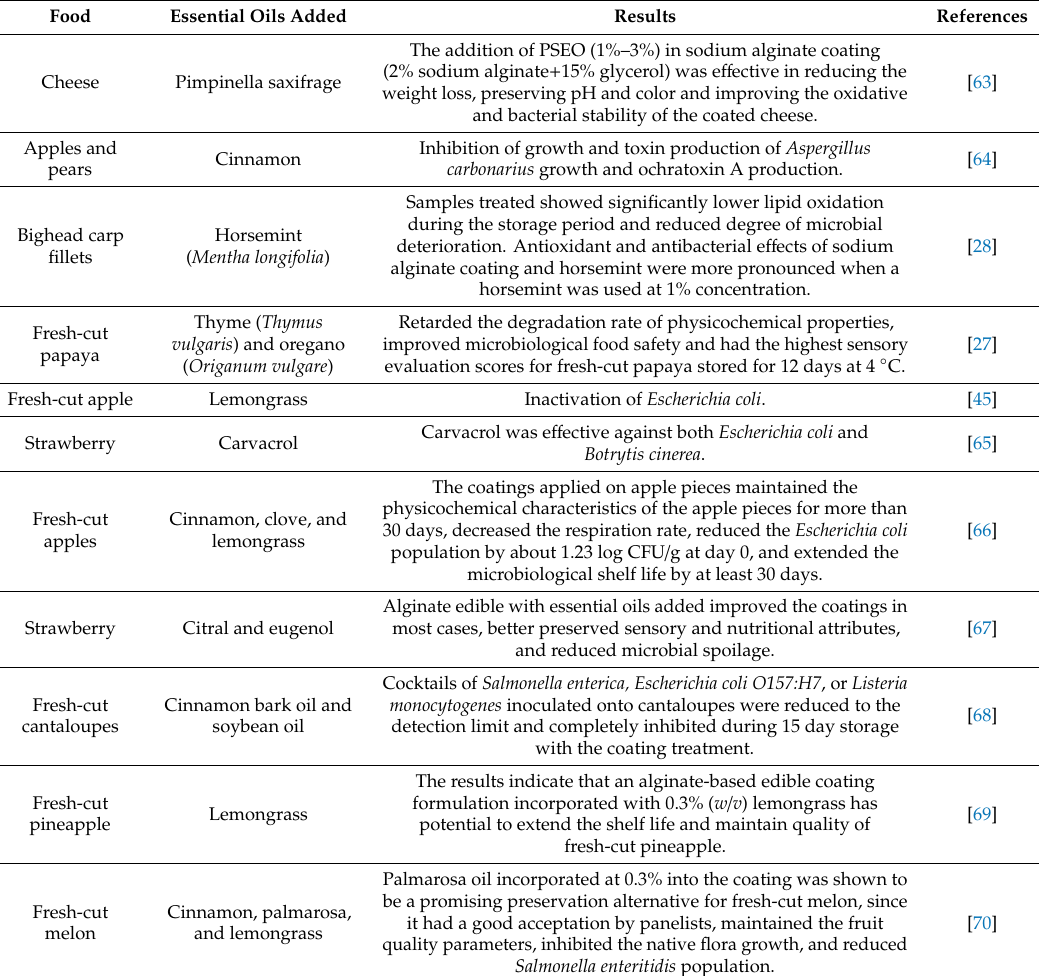
Table 2. Films based on sodium alginate with essential oil additives used in the food